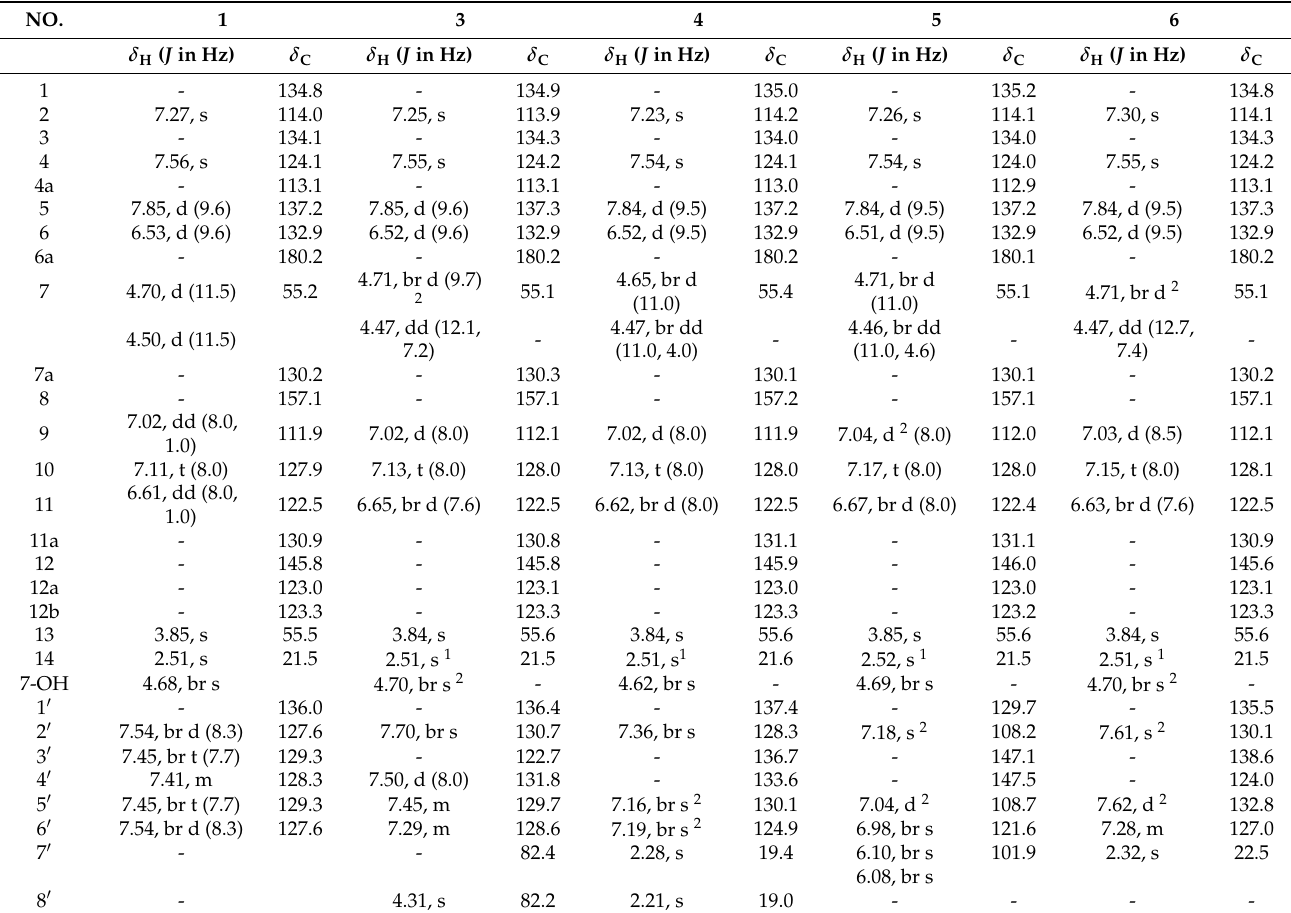
1 signals were overlapped with DMSO. 2 signals were overlapped with others. Compound 5 was obtained as green-yellow solid, UV (MeOH) λ max (log ε ): 273 (5.99), 355 (5.98), 415 (5.95) nm. IR (KBr) ν max : 3346, 2917, 1635, 1596, 1502, 1489, 1460, 1263, 1239, 1029 cm − 1 . HR-ESI-MS analysis afforded an [M + H] + ion at m/z 440.1490 (calcd for C 27 H 22 NO 5 , 440.1492) giving the molecular formula of 5 as C 27 H 21 NO 5 . 1 H-NMR (600 MHz, DMSO- d 6 ) and 13 C-NMR (150 MHz, DMSO- d 6 ) data, Table 1. The 1 H-NMR and 13 C-NMR spectra of 5 resembled that of 1 , except that the resonances at δ 6 (cid:48) ), 7.45 (H-3 (cid:48) /H-5 (cid:48) ), 7.41 (H-4 (cid:48) ) and δ C 136.0 (C-1 (cid:48) ), 127.6 (C-2 (cid:48) /C-6 (cid:48) ), 129.3 (C-3 (cid:48) /C-5 (cid:48) ),